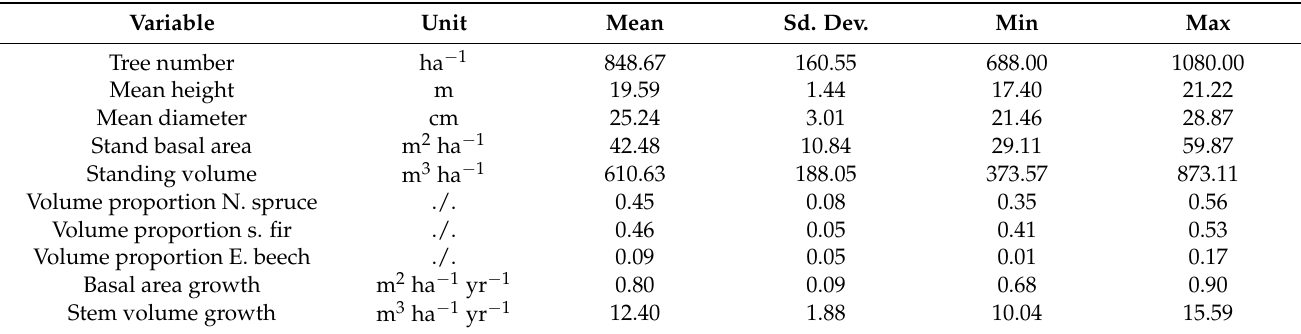
Table 2. Overview of key stand characteristics of the selection forest experimental plot FRY 129. The table reflects the mean, standard deviation, minimum and maximum values of the 6 subplots FRY 129/11, 12, 21, 22, 31, and 32 at the last survey in 2018. The reported mean periodical growth rates refer to the period 2011–2018. Variable Unit Mean Sd.